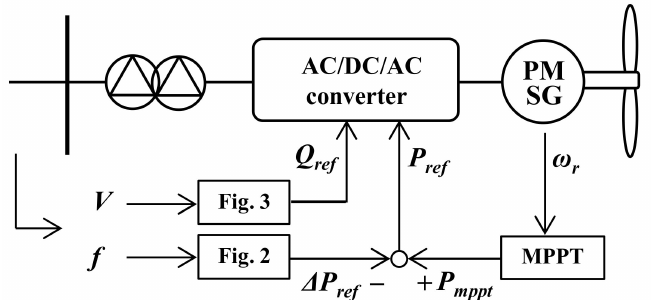
Figure 1. Control scheme of the VSWG used to enhance transient stability.